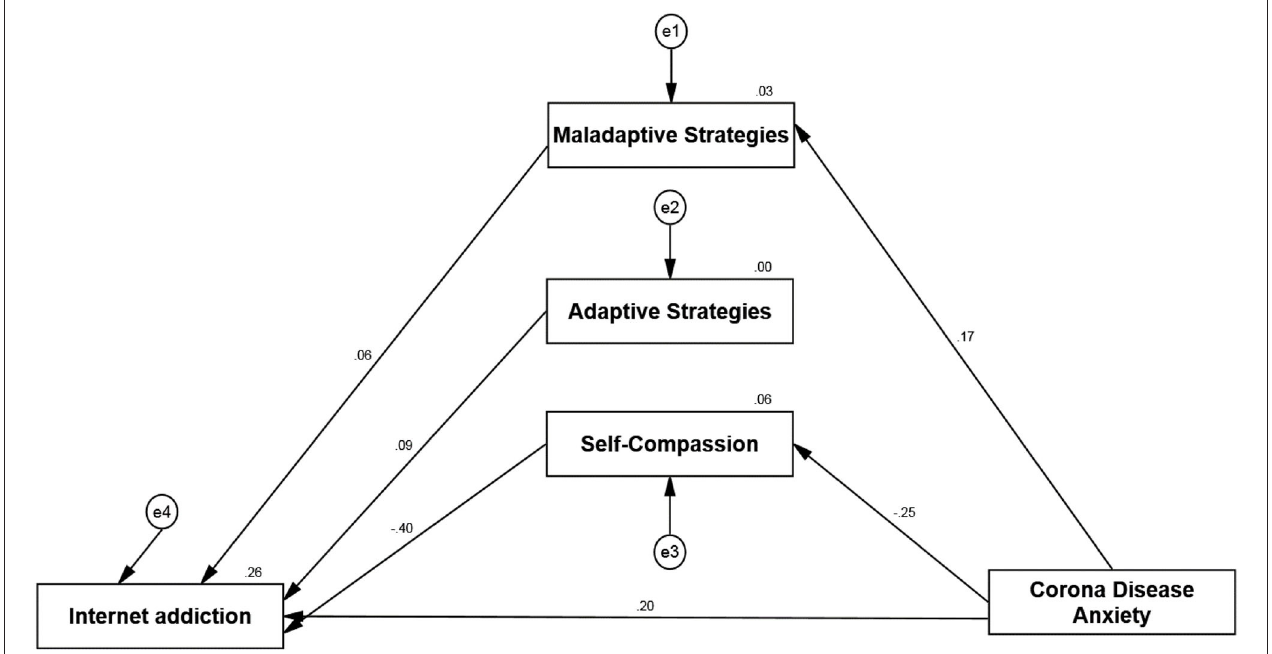
FIGURE 1 | Examining the indirect effect of corona disease anxiety on internet addiction through self-compassion and emotion